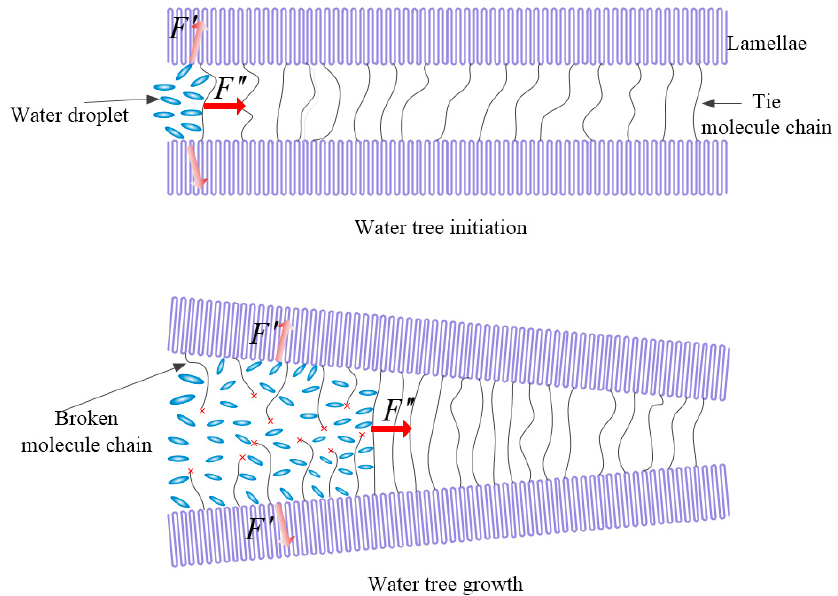
Figure 8. Schematic electromechanical mechanism of water-tree initiation (above panel) and growth (bottom panel) in SEBS/PP composites. F ’ and F ” in represent the impact forces of water microbeads on the lamellae and the molecular chains connecting adjacent lamellae, respectively.